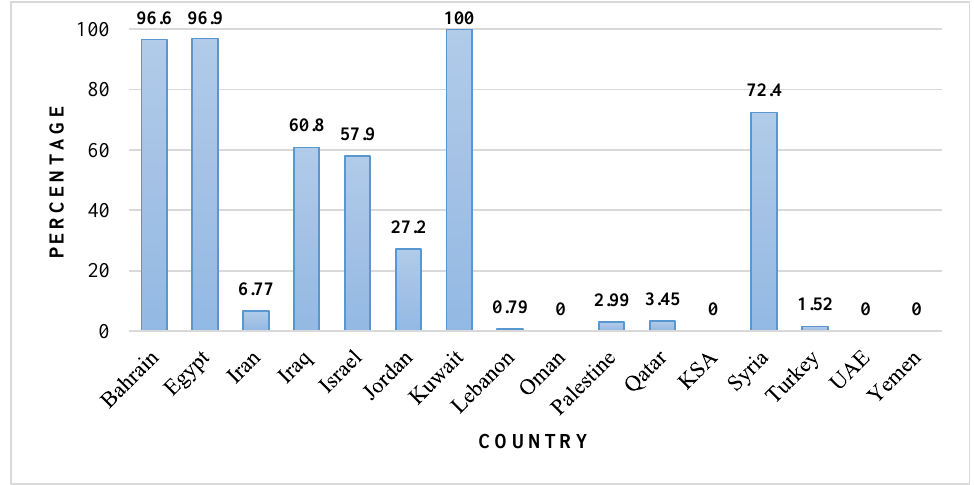
Figure 5. The percentage of the total renewable water resources originating outside a country in 2014. A country with a dependency ratio equal to 0% does not receive any water from neighboring countries, whereas a country with a dependency ratio equal to 100% receives all its renewable water resources from upstream countries. The data is acquired from: https://idea.usaid.gov.